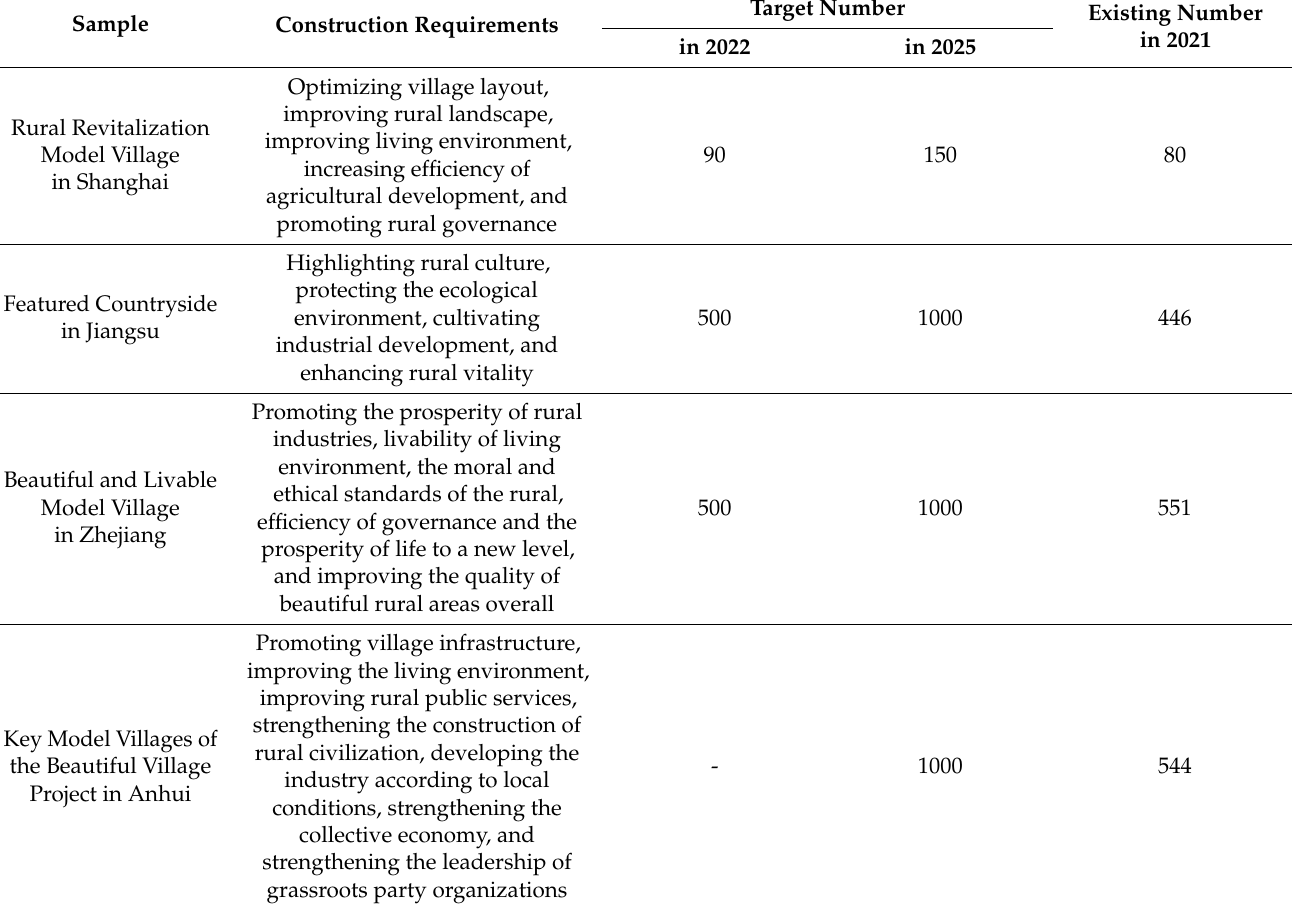
Table 1. The sample rural revitalization model villages in the YRD 1